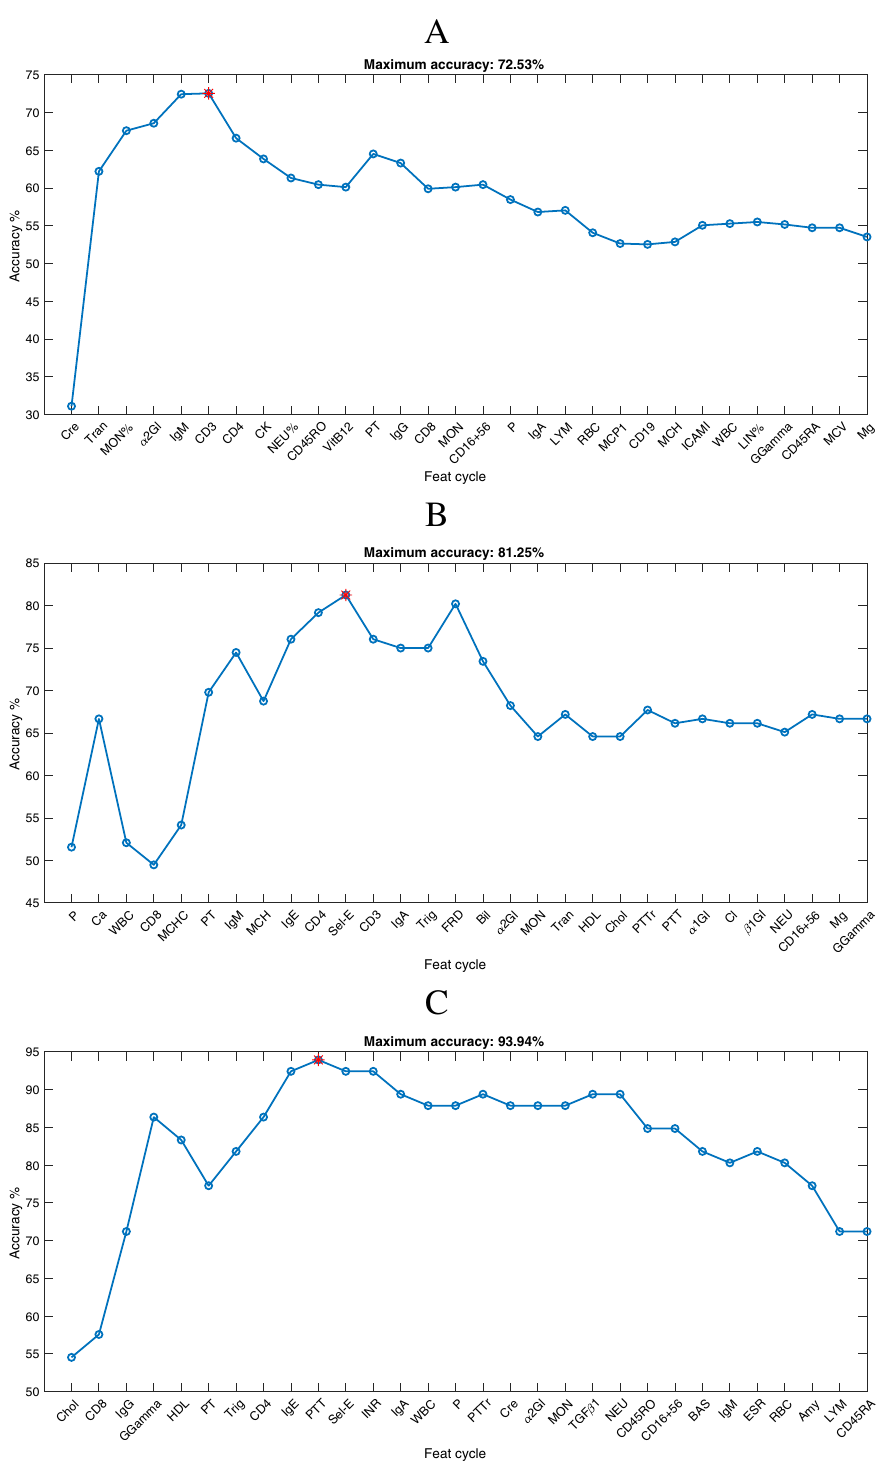
Figure 2. Classification accuracy trend of the ALS versus LMND recognition model as a function of the first 30 selected blood analytes. The red marker indicates the maximum accuracy. ( A ) The result achieved on the all-patients dataset (i.e., maximum accuracy of 72.53% combining the first 6 ranked features). ( B ) The result achieved on the hSc dataset (i.e., maximum accuracy of 81.25% combining the first 11 ranked features). ( C ) The result achieved on the 1-y dataset (i.e., maximum accuracy of 93.94% combining the first 10 ranked